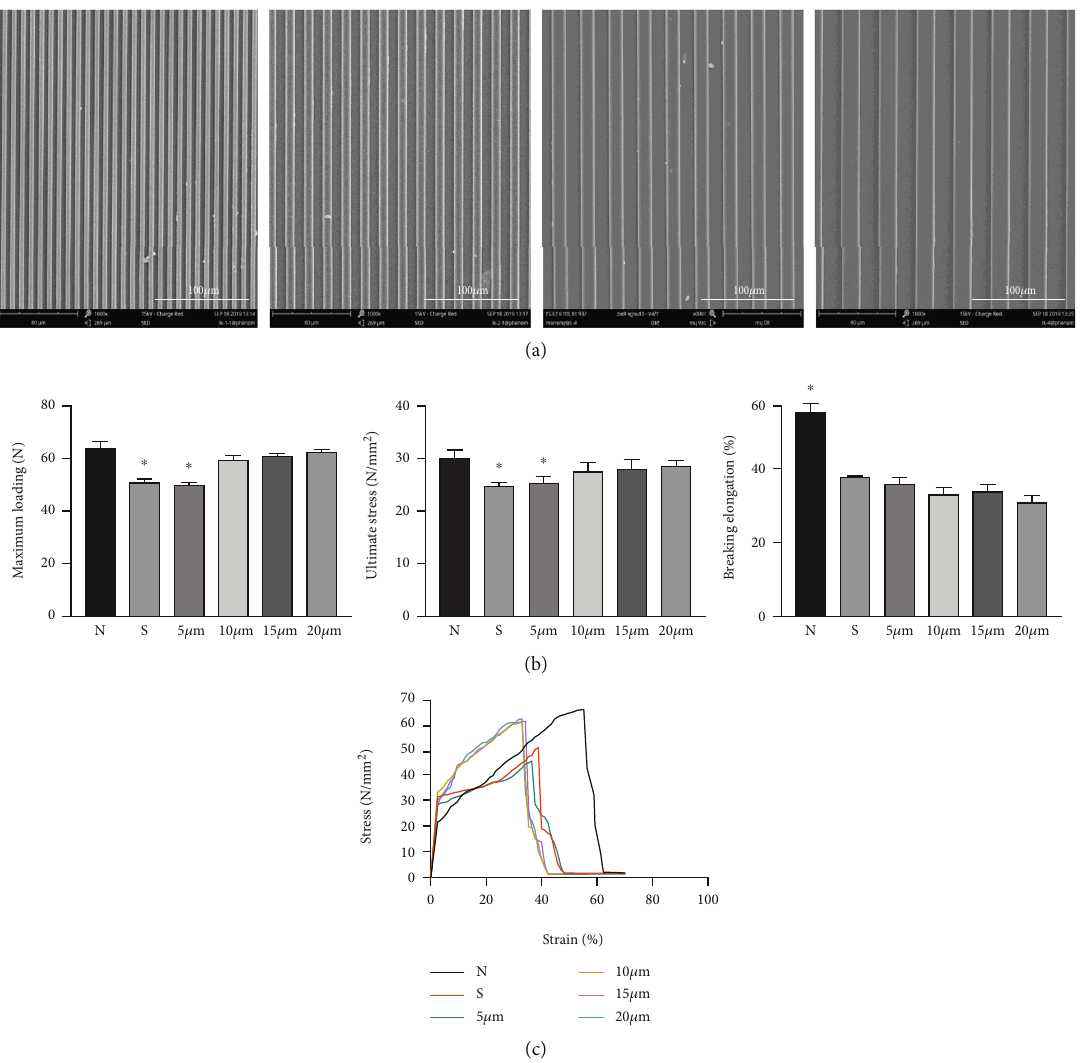
Figure 3: SEM images of SF fi lms with bionic microstructures at 5, 10, 15, and 20 μ m, respectively (magni fi cation at × 1000) (a). The maximum loading, ultimate stress (N/mm 2 ), and breaking elongation (%) of SF fi lm groups and native tendon were measured (b). The strain-stress curves of samples in di ff erent groups (c). Group N was the native tendon group, group S was the SF fi lm group with a smooth surface, and the other groups were SF fi lm groups with di ff erent microstructure sizes (5, 10, 15, and 20 μ m). ∗ indicates p < 0 : 05